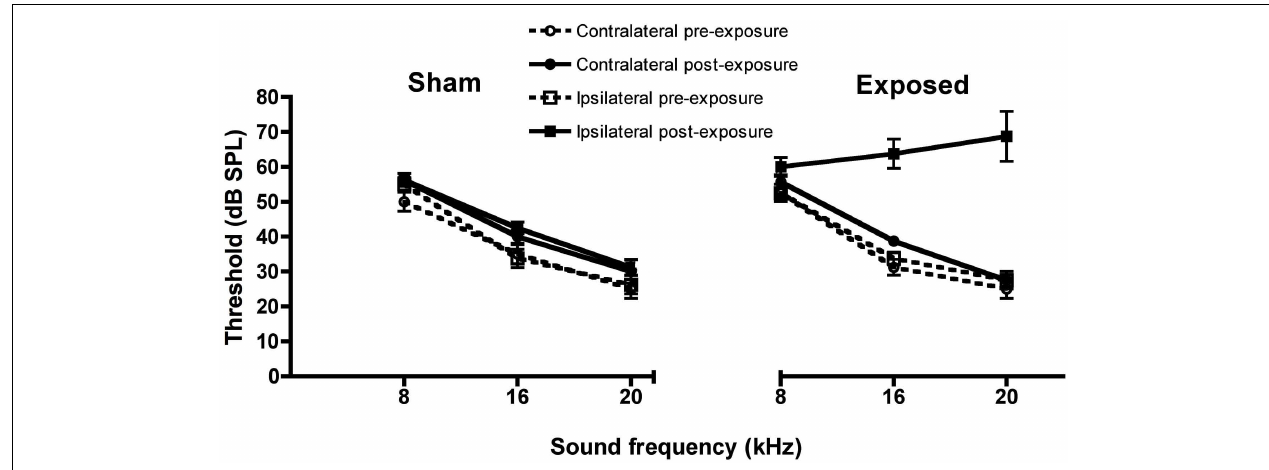
FIGURE 1 |Auditory brainstem-evoked response thresholds for the ipsilateral and contralateral ears of acoustic trauma-exposed and sham control animals before and after exposure, as a function of intensity in dB SPL and frequency in kHz. Bars represent means ± 1 SE.